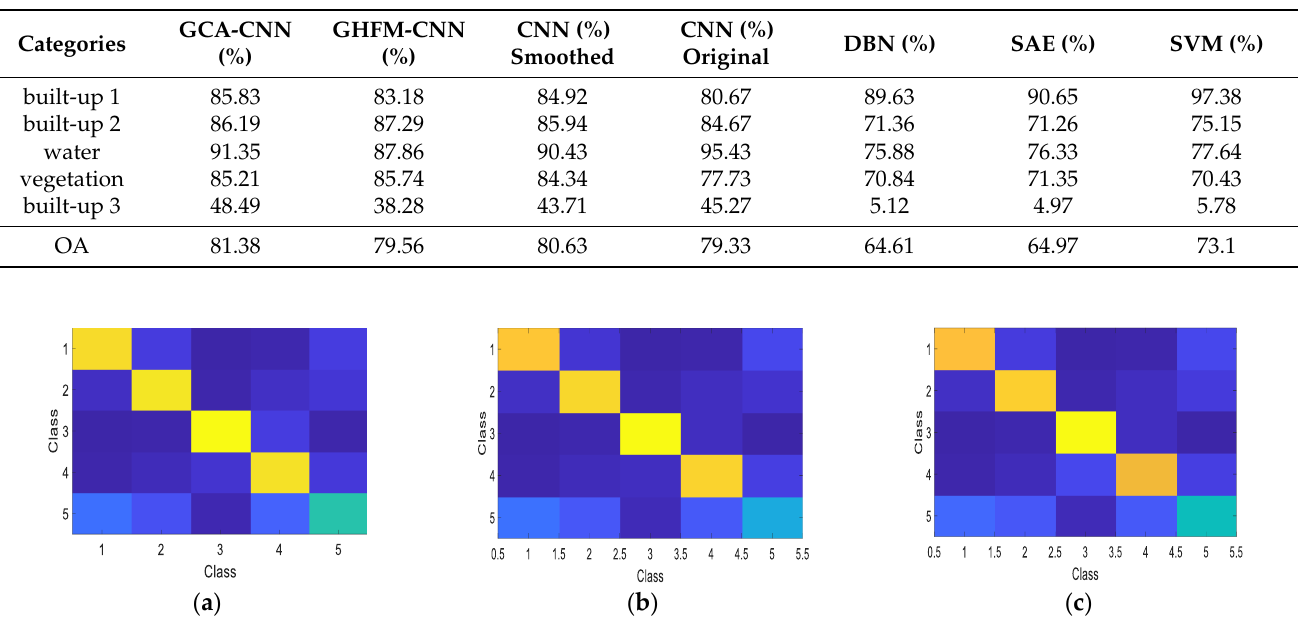
Figure 10. The converging curve of GCA-CNN and GHFM-CNN on the SanFrancisco-Bay image. For Figure 10, there is a series of alternations of peaks and valleys in the training error curve of the GCA-CNN. This can be explained by the high level of speckle noise and the inter-class similarity on the training samples. Because of these disturbances, the parameters of the GCA cannot converge to the optimized value but wander around the optimized parameters. This mechanism leads to the massive peaks in Figure 10. The OAs and the accuracies for each category of the proposed and compared algorithms are listed in Table 2 for comparison. For better visualization, the corresponding confusion matrices of the GCA-CNN, GHFM-CNN and the OI-CNN are given in Figure 11. In Figure 12, the result maps of all the algorithms are illustrated. In Table 2, it can be observed that the proposed GCA-CNN still achieves the highest OA (81.38%), which demonstrates the superiority of the proposed algorithm over the compared algorithms on the real SAR image. The CNN algorithm with smoothed, and the original SAR image as the input obtains the second and third highest OAs. This result indicates that the superiority of the proposed GCA-CNN derives from the adaptive fusion of FM 1 and FM 2 . However, the GHFM-CNN achieves even lower accuracy than the CNN. Table 2. Accuracies of algorithms on SanFrancisco-Bay SAR image.